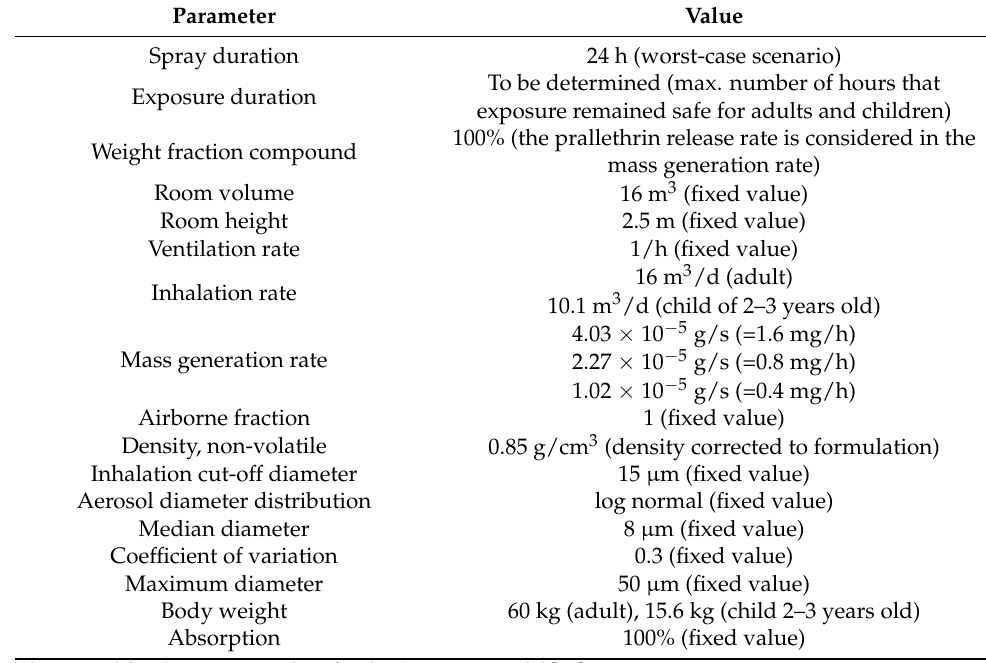
Table 1. Summary of parameters for the ConsExpo model “Inhalation exposure: exposure to spray— spray”.